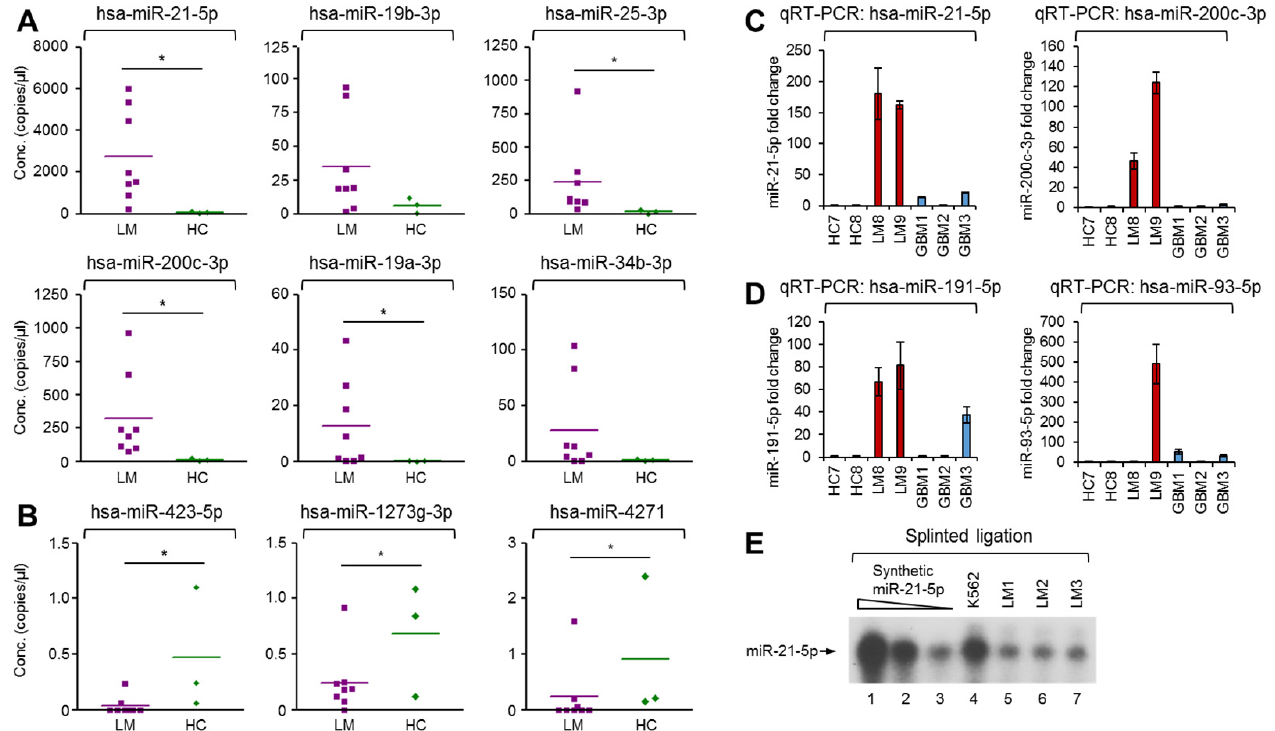
Figure 4. Biochemical verification of biased miRNA expression in EVs derived from LM and HC by ddPCR. ( A ) 6 upregulated miRNAs were analyzed by ddPCR (ddPCR Supermix for Probes; hsa-miR-21-5p, hsa-miR-19b-3p, hsa-miR-25-3p, hsa-miR-200c-3p, hsa-miR-19a-3p, and hsa-miR-34b-3p) in EVs from LM (purple rectangle, n = 8) vs HC (green rhombus, n = 3). ( B ) 3 downregulated miRNAs were analyzed by ddPCR (QX200 ddPCR EvaGreen Supermix; hsa-miR-423-5p, hsa-miR-1273g-3p, and hsa-miR-4271) in EVs from LM (purple rectangle, n = 8) vs HC (green rhombus, n = 3) (Mann-Whitney U test, * p < 0.05). ( C ) 2 upregulated miRNAs were analyzed by qRT-PCR (TaqMan Advanced miRNA Assay probes; miR-21-5p and miR-200c-3p) in CSF EVs from 2 LMs (LM8 and LM9), 2 HCs (HC7 and HC8) and 3 glioblastoma multiforme patients (GBM1-3). ( D ) 2 upregulated miRNAs were analyzed by qRT-PCR (TaqMan Advanced miRNA Assay probes; hsa-miR-191-5p and hsa-miR-93-5p) in CSF EVs from 2 LMs (LM8 and LM9), 2 HCs (HC7 and HC8), and 3 glioblastoma multiforme patients (GBM1-3). The data represent the mean values of three independent experiments ( n = 3) and error bars in the graph represent ± standard deviation. ( E ) Splinted ligation was performed with [ 32 P] 5 (cid:48) -end-labeled oligonucleotide probe specific for mature miR-21-5p as described in Supplementary Materials and Methods. The experiments were repeated at least three times with similar results. The data shown in panel ( E ) is a representative